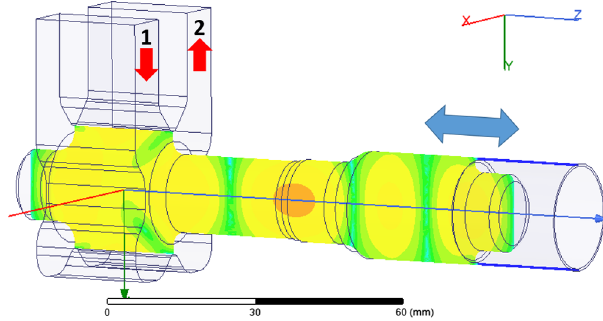
FIG. 7. Geometry of the variable rf phase shifter and electric field distribution in a symmetry plane.